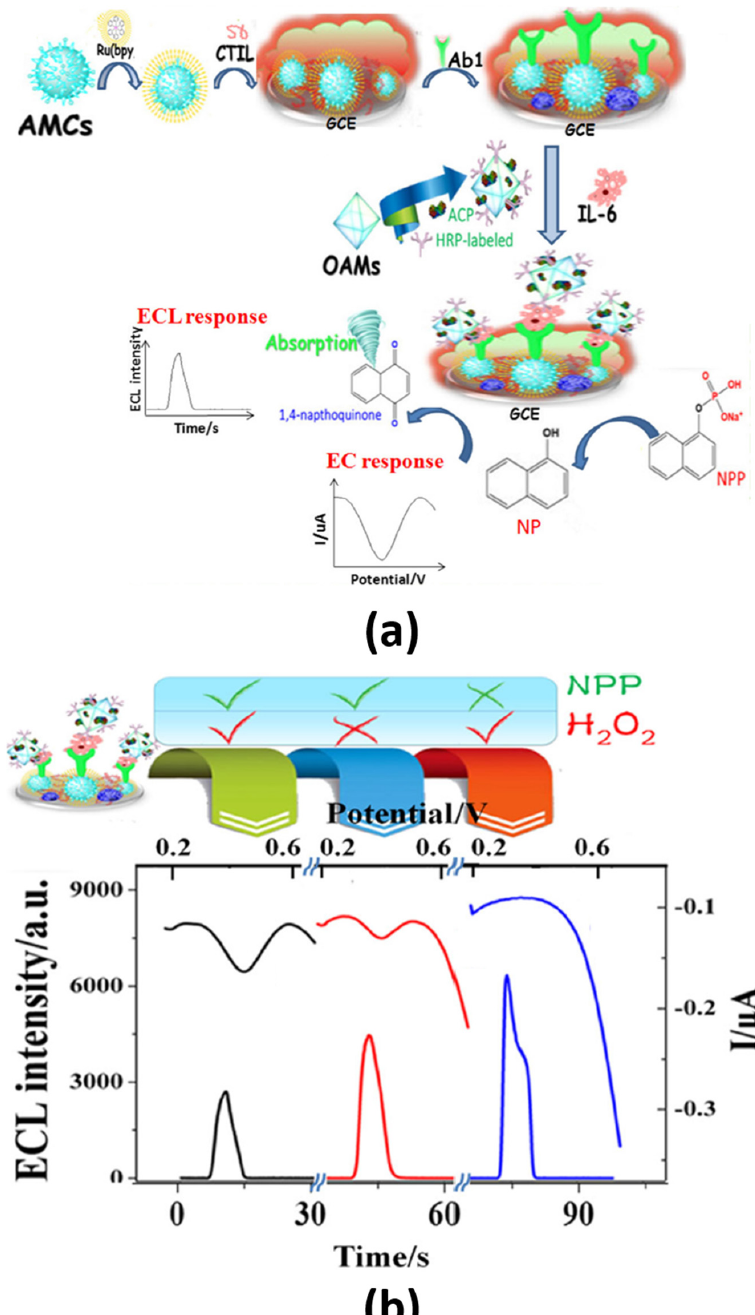
Figure 8. ( a ) Electrochemical and ECL dual response sandwich immunosensor involving different TiO 2 nanoarchitectures both as electrode modifiers and nanocarriers; ( b ) real DPV and ECL-time curves obtained with the developed immunosensor in buffer containing 5 mM NPP and 15 mM H 2 O 2 (black curves), 5 mM NPP only (red curves) and 15 mM H 2 O 2 only (blue curves). Reproduced from [48] with permission.